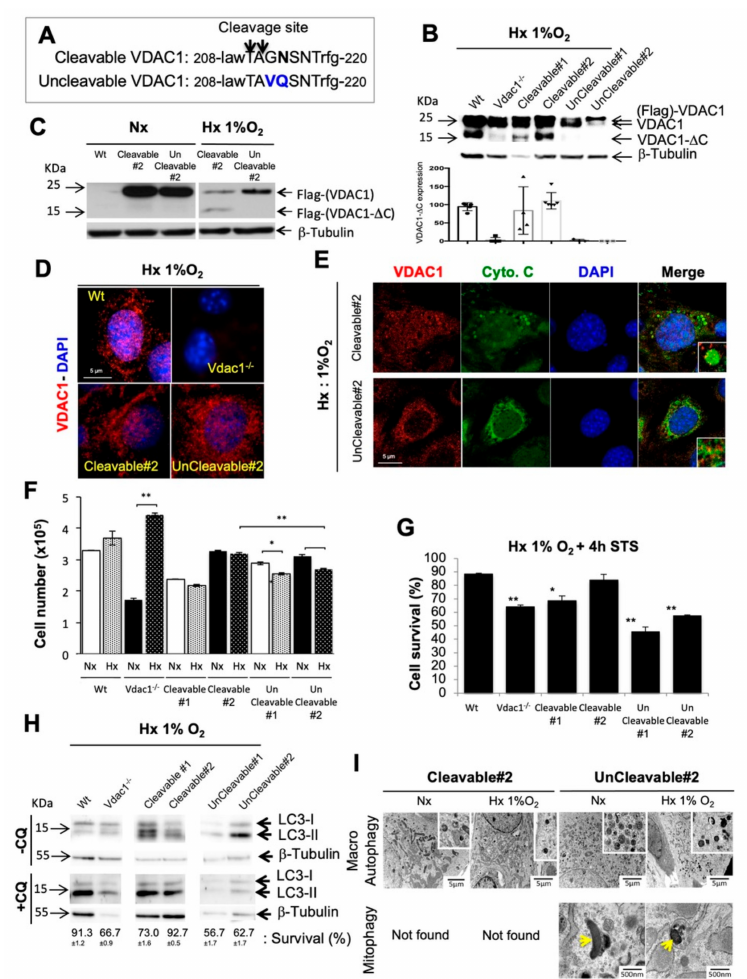
Figure 1. Characterization of cleavable and uncleavable clones of Voltage-dependent anion channel 1 (VDAC1) in normoxia and hypoxia. ( A ) Schematic representation of mutations made at the cleavage site of VDAC1. ( B ) Wt, Vdac1 − / − , Cleavable#1 / #2 and UnCleavable#1 / #2 cells were incubated in Hx 1% O 2 for 72 h and cell lysates were analyzed by immunoblotting for VDAC1. β -tubulin was used as a loading control. Bottom panel showed quantification of VDAC1- ∆ C presence in at least four di ff erent immunoblots. ( C ) Vdac1 − / − , Cleavable #2 and UnCleavable #2 cells were incubated in Hx 1% O 2 for 72 h and cell lysates were analyzed by immunoblotting for Flag (mouse monoclonal antibody). β -tubulin was used as a loading control. ( D ) Immunofluorescence of VDAC1 in Wt, Vdac1 − / − , Cleavable#2 and UnCleavable#2 cells in Hx 1% O 2 for 72 h. ( E ) Immunofluorescence to VDAC1 and cytochrome c (Cyto.C) in Cleavable#2 and UnCleavable#2 cells in Hx 1% O 2 for 72 h. ( F ) Cell lines were seeded at the same density and incubated in Nx or Hx 1% O 2 for 72 h. The mean ± SEM is representative of four independent experiments carried out in duplicate. ( G ) Wt, Vdac1 − / − , Cleavable#1 / #2 and UnCleavable#1 / #2 cells were incubated in Hx 1% O 2 for 72 h and challenged with staurosporin (STS) (1 µ M) for 4 h. Cell mortality was measured using an ADAM cell counter. ( H ) Wt, Vdac1 − / − , Cleavable#1 / #2 and UnCleavable#1 / #2 cells were incubated in Hx 1% O 2 for 72 h in the presence of chloroquine (CQ) and cell lysates were analyzed by immunoblotting for LC3-I / II. β -tubulin was used as a loading control. Cell viability was measured using an ADAM cell counter. The mean ± SEM is representative of three independent experiments carried out in duplicate. ( I ) Representative electron micrographs of mitochondria from Cleavable#2 and UnCleavable#2 cells incubated in normoxia (Nx) or Hx 1% O 2 for 72 h. Yellow arrows show mitochondria engulfed in autophagosomes / autolysosomes. A * p < 0.05 and ** p < 0.005 show significant di ff erences. The uncropped Western Blot figures in Figure